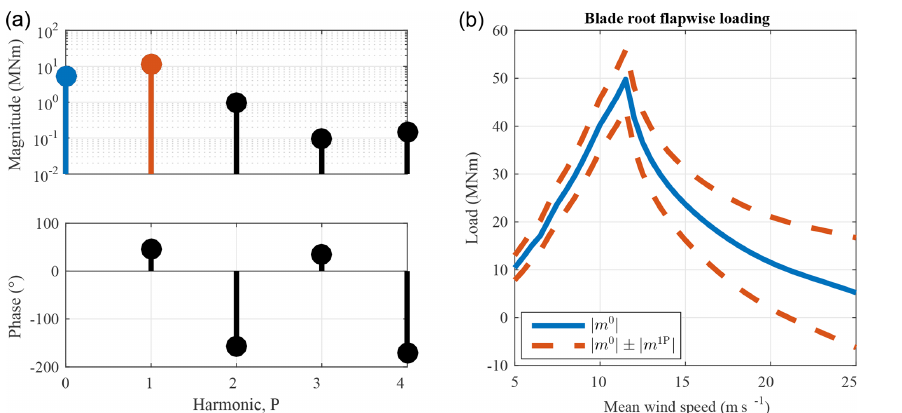
Figure 4. Load harmonic magnitude | m i P | and phase φ i P for the zeroth through fourth periodic harmonic of the blade root load in the flapwise direction (a) of the SUMR-13A at 25ms − 1 . Mean load (blue) superimposed with the 1P harmonic amplitude (red) with respect to wind speed (b) used to estimate fatigue and extreme loads. Table 2. Structural loads evaluated in this article. Each component has loads in multiple directions and experiences the peak load and greatest contribution to fatigue loads at different wind speeds. N B denotes the number of blades on the rotor. Loads that are nearly constant across wind speeds do not have a defined peak wind speed (N/A). The dominant wind speed contributing to fatigue is determined by analyzing the relative fatigue contribution, p ( u ) m n P from Eq. (10), across wind speeds. Component Dominant Wöhler Load direction, Wind speed Dominant wind speed harmonic exponent name at peak load contributing to fatigue load Below